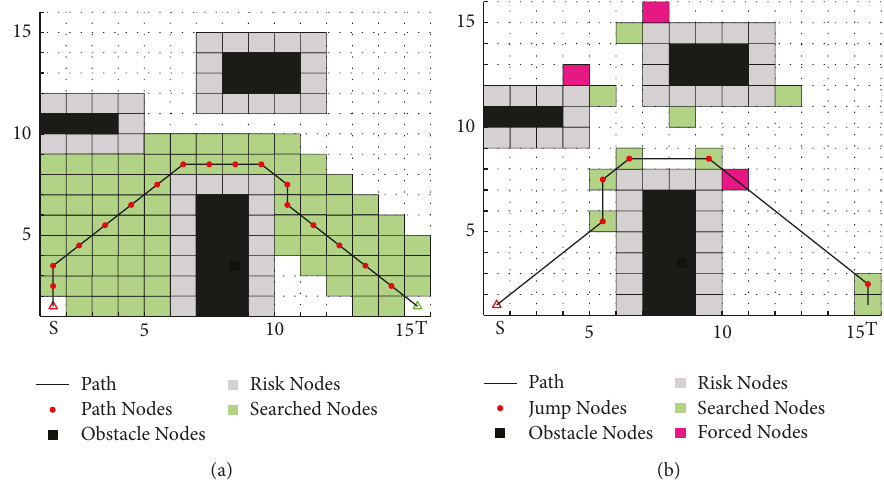
Figure 5: Comparison of path planning. (a) Traditional A ∗ algorithm. (b) Improved A ∗ algorithm based on jump point